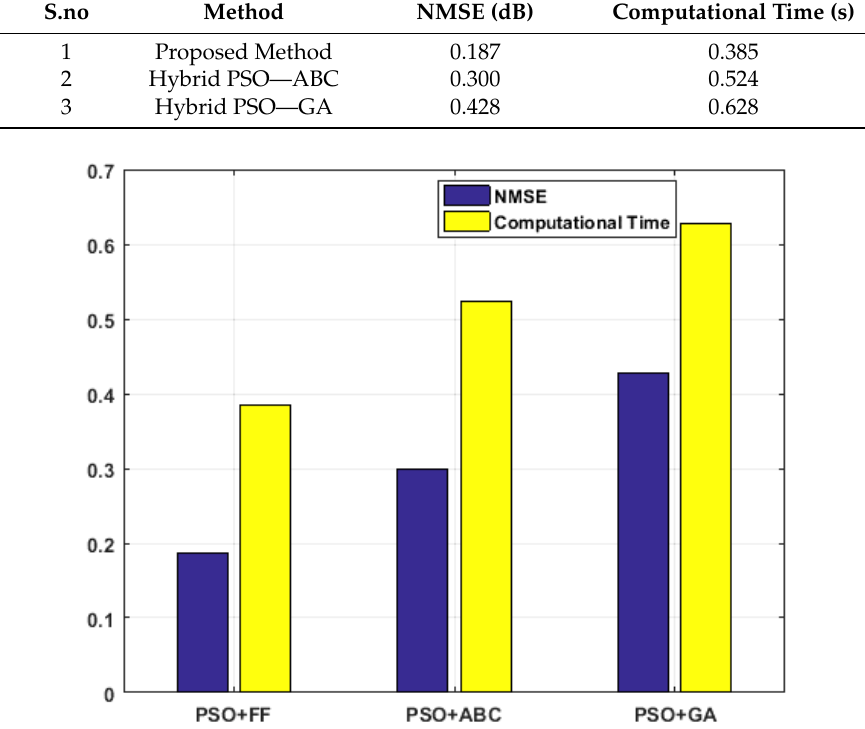
Table 2. Comparison of the proposed method with other hybrid algorithms.